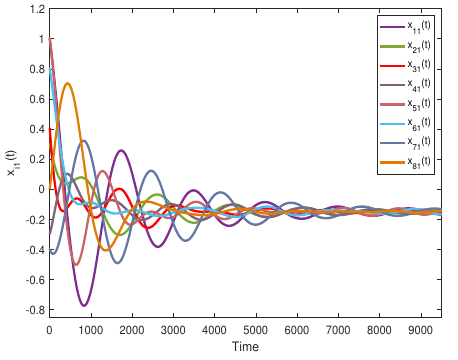
Figure 9. The states of x i 1 ( t ) .